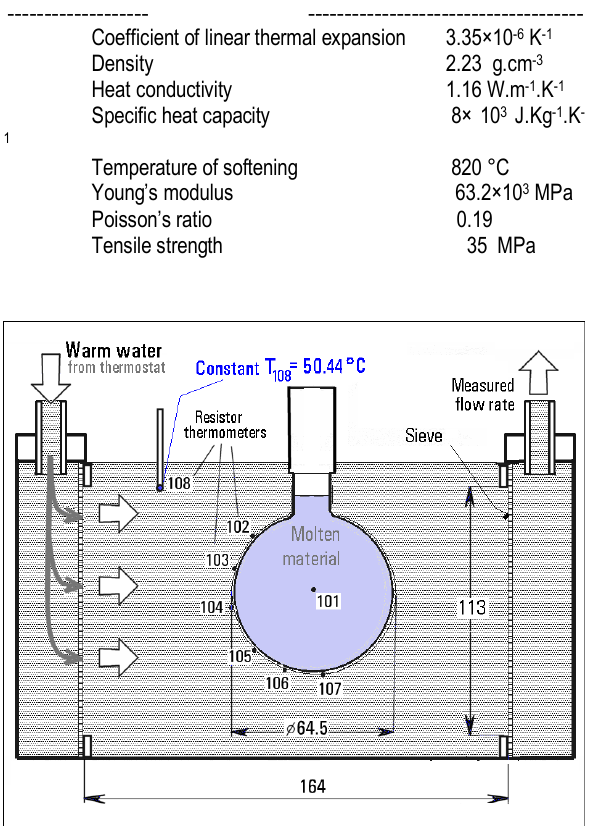
Fig. 18. E xperimental set-up and its geometry. Constant- temperature water carrying the melting heat is delivered at the left-hand side through the fine vertical sieve. It flows past the tested capsule model and leaves (again through a sieve) at right, returning to the thermostat which keeps its constant temperature. The spherical model is scaled up substantially from the actual capsules to make possible detailed studies of the internal phase